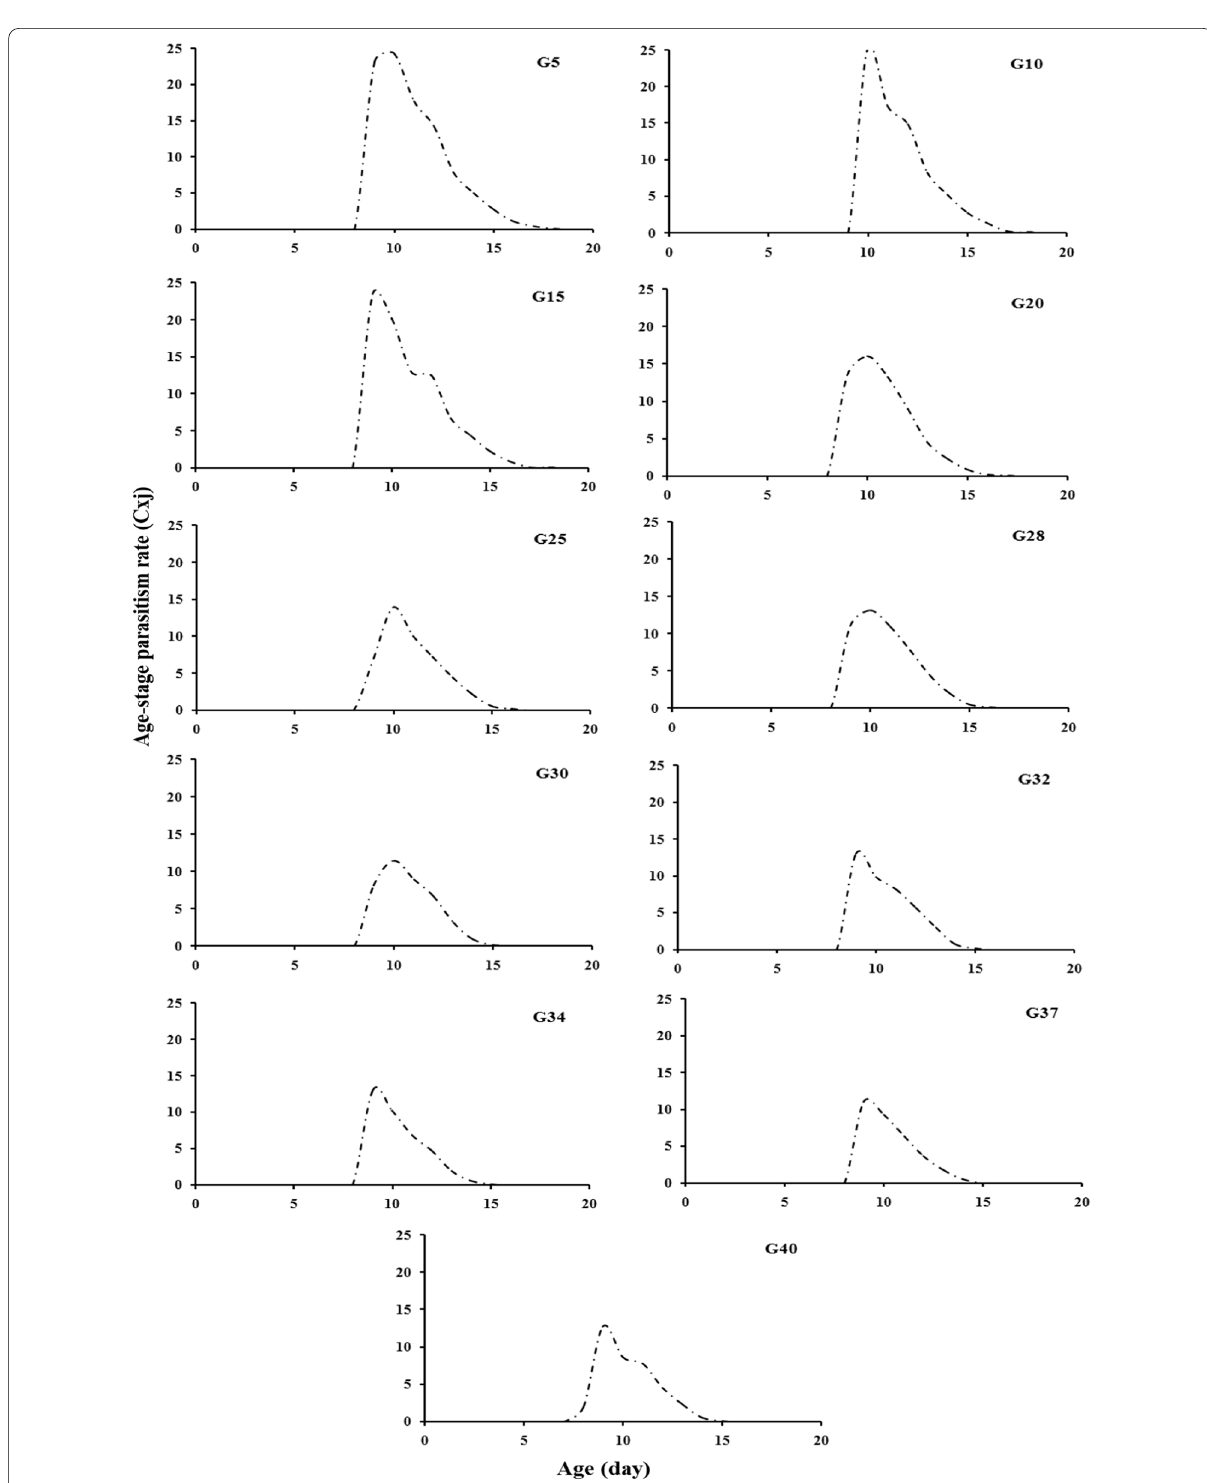
Fig. 4 The age-stage parasitism rate ( c xj ) of sequential generations of T. embryophagum reared on S. cerealella